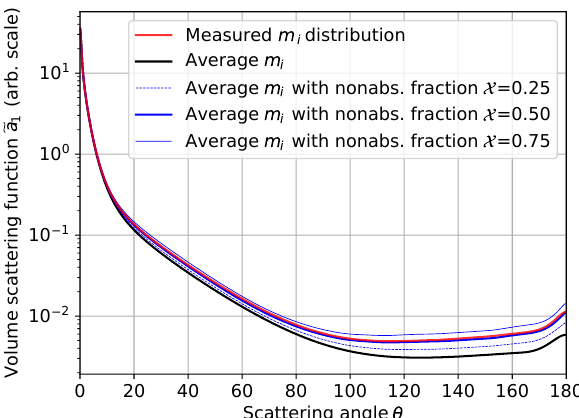
Figure 9. Volume scattering function of dust at λ = 355nm (arbi- trary scale) using either the m i distribution (red) measured by Kan- dler et al. (2011), the average m i of these measurements (black), or applying the non-absorbing fraction parameterization with different X